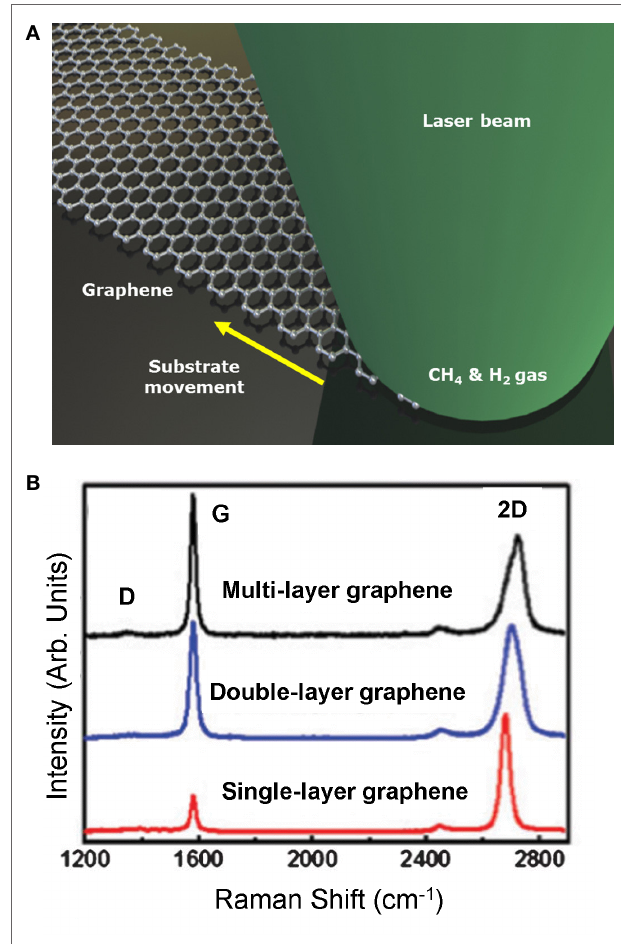
FiGURe 10 | (A) Schematic of the laser induced CVD process, and (B) mea-sured Raman as a function of the number of graphene layers. Reprinted with permission from Park et al. (2011). Copyright 2011, American Institute of Physics.